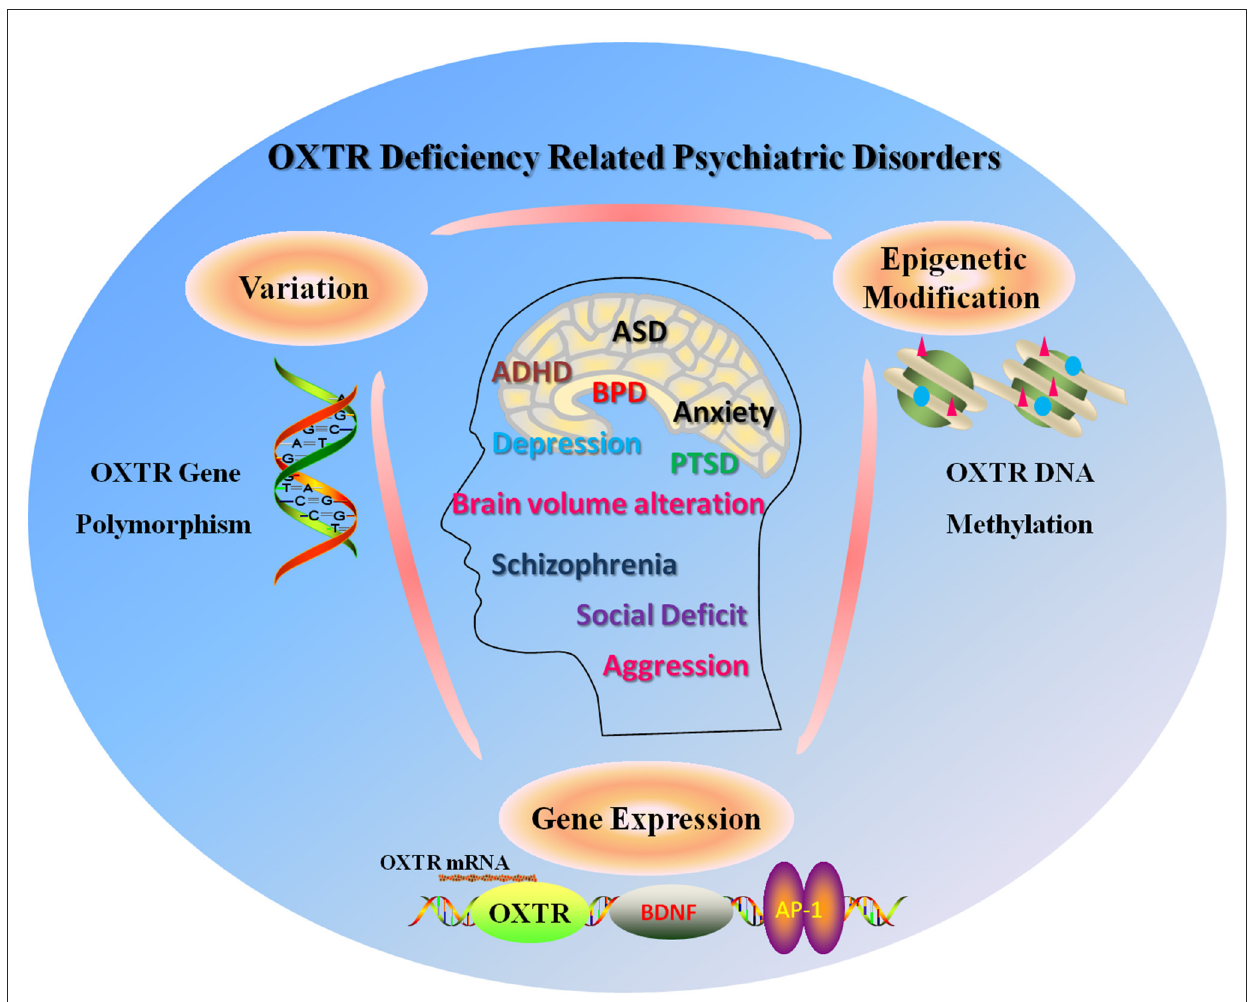
FIGURE5 Involvement of OXTR variation, epigenetic modification, and gene expression in typical psychiatric disorders or alteration in brain development, including ASD, ADHD, BPD, PTSD, anxiety, depression, brain volume alteration, schizophrenia, and social